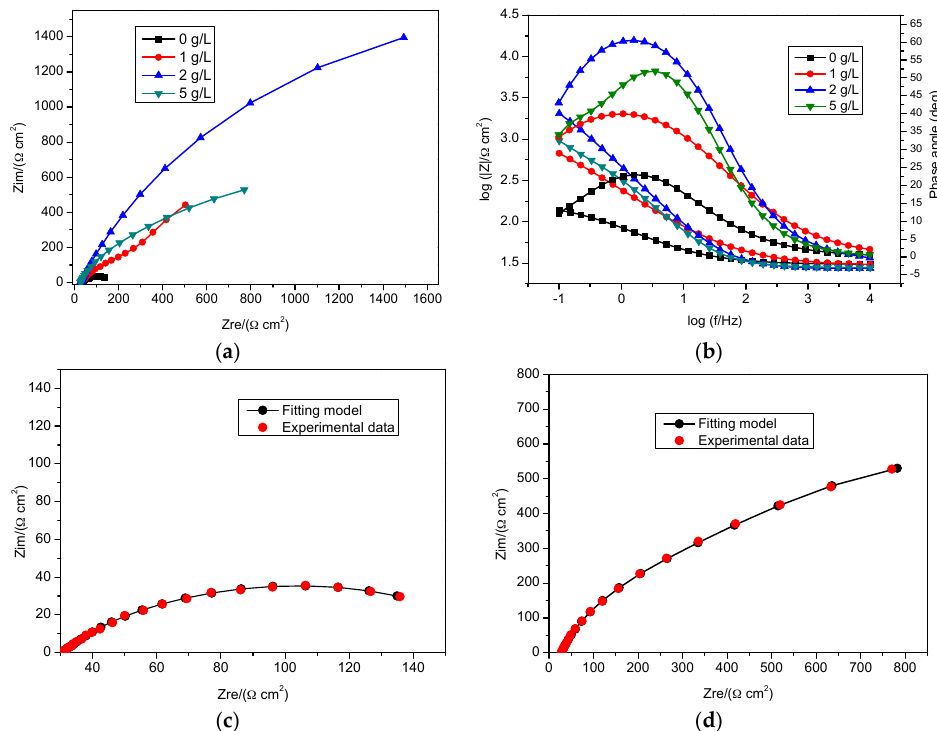
Figure 3. Impedance spectra for mild steel in bicarbonate chloride solution in the absence and presence of sodium nitrite at 2000 rpm at room temperature: ( a ) Nyquist plots and ( b ) Bode and impedance magnitude vs. frequency plots; ( c ) Nyquist plots (0 g/L nitrite) and ( d ) Nyquist plots (5 g/L nitrite) for fitted and experimental data. Table 1. Impedance parameters for mild steel in bicarbonate/chloride solution in the absence and presence of different concentration of sodium nitrite at 2000 rpm at room temperature. Inh. Conc